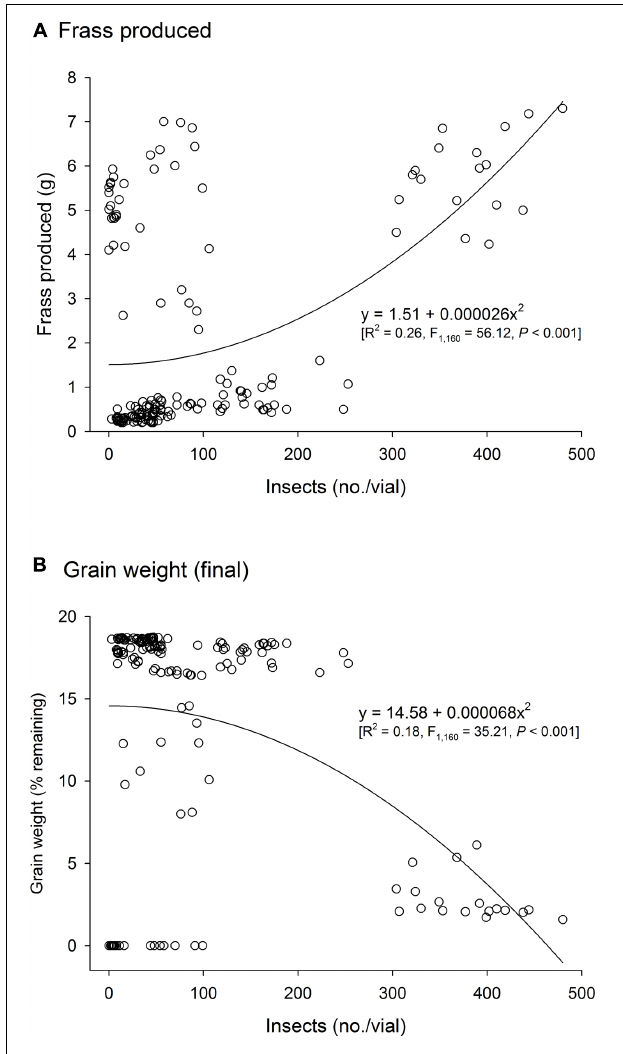
FIGURE 8 | Frass production (A) and final grain weight (%) (B) produced by three competing species of stored-grain insects, Rhyzopertha dominica , Sitophilus oryzae, and Trogoderma granarium . The symbols represent the observed